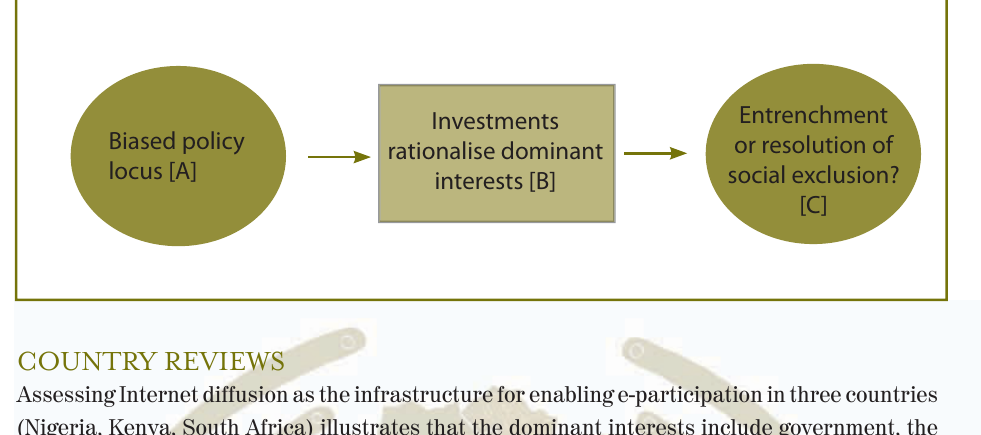
COUNTRY REVIEWS